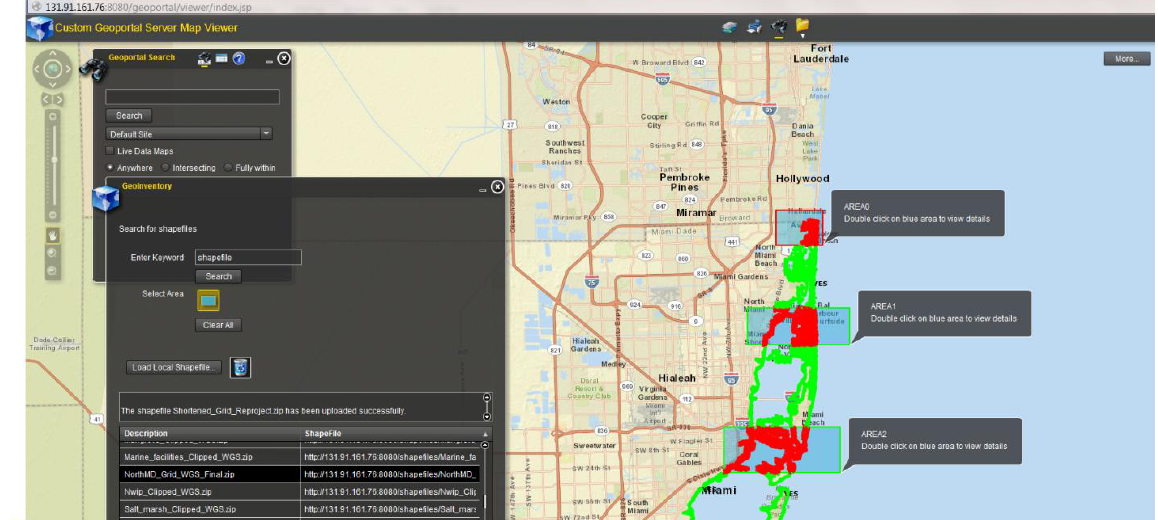
Figure 6. A user may select and compare the attributes of several areas